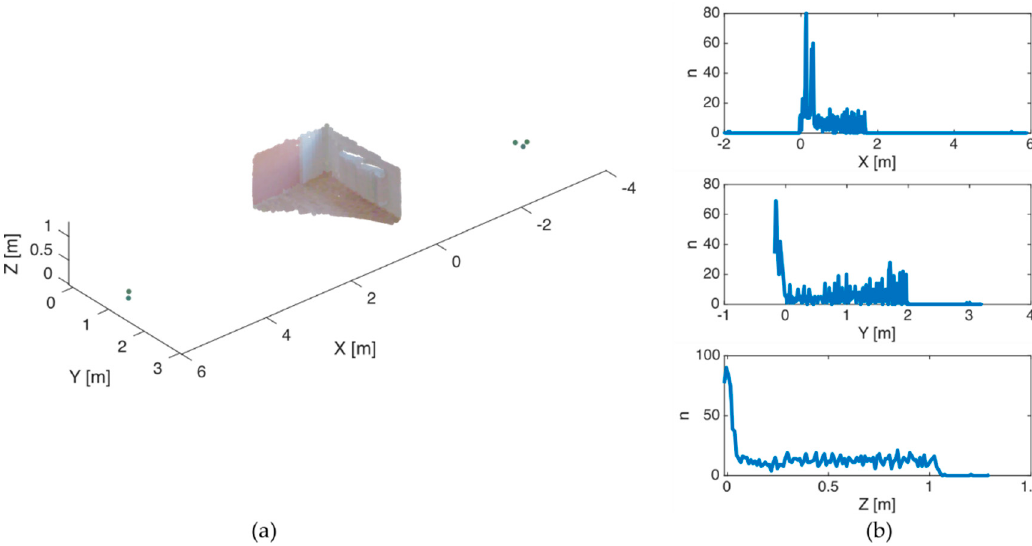
Figure 3. Distribution of points in the point cloud model: ( a ) Input point cloud; ( b ) Histograms of all coordinate axes.